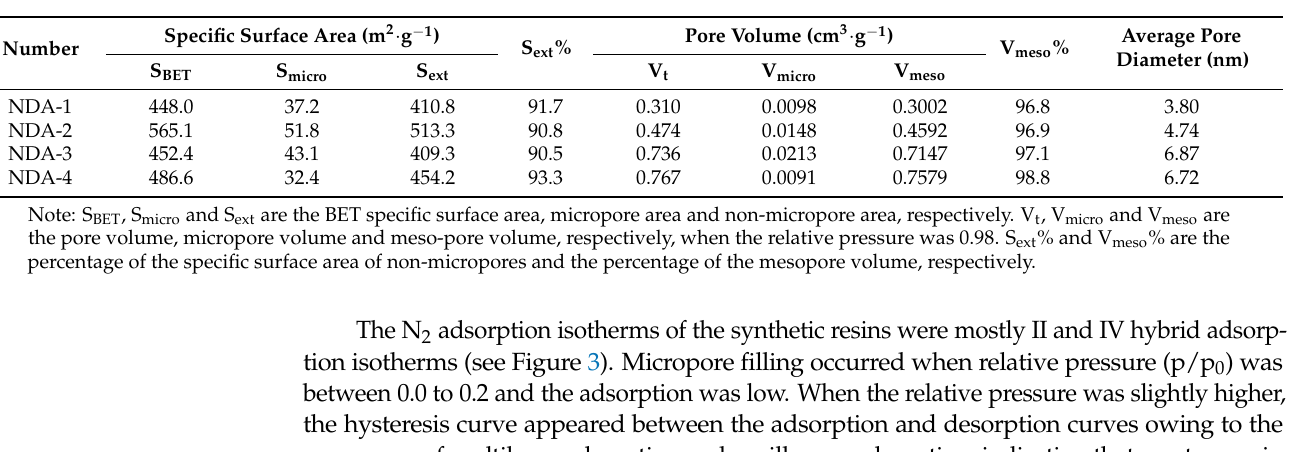
Table 1. Characterization of